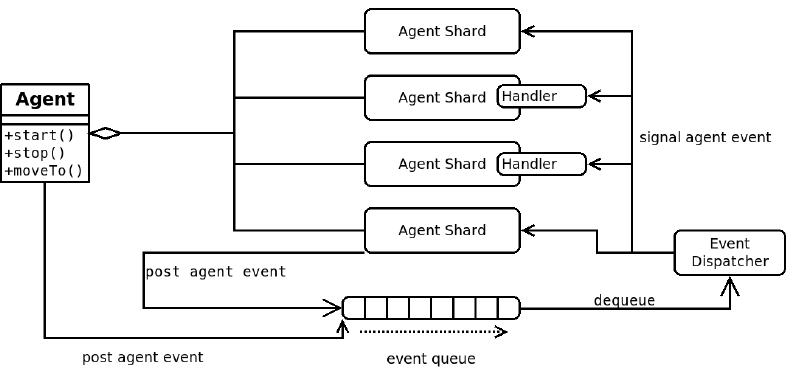
Figure 4. A perspective on how events are processed in a Composite Agent